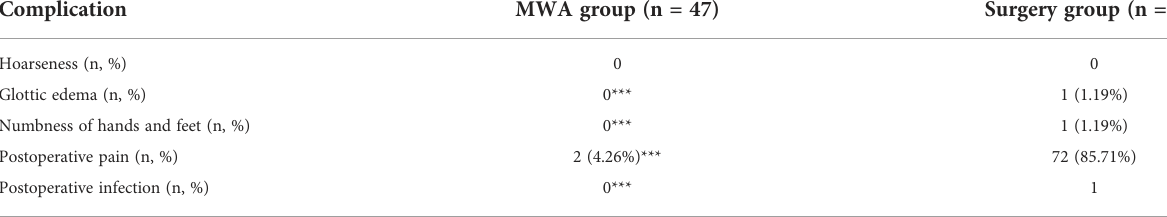
TABLE 4 Postoperative complications of patients with Bethesda IV nodules treated with MWA and surgery.